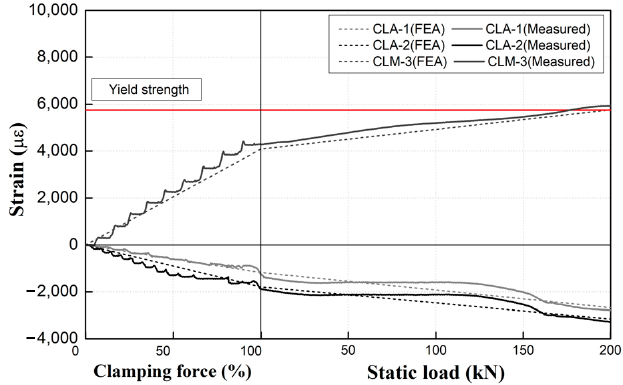
Figure 14. Comparison of experimental and analytical results for a new tension clamp.